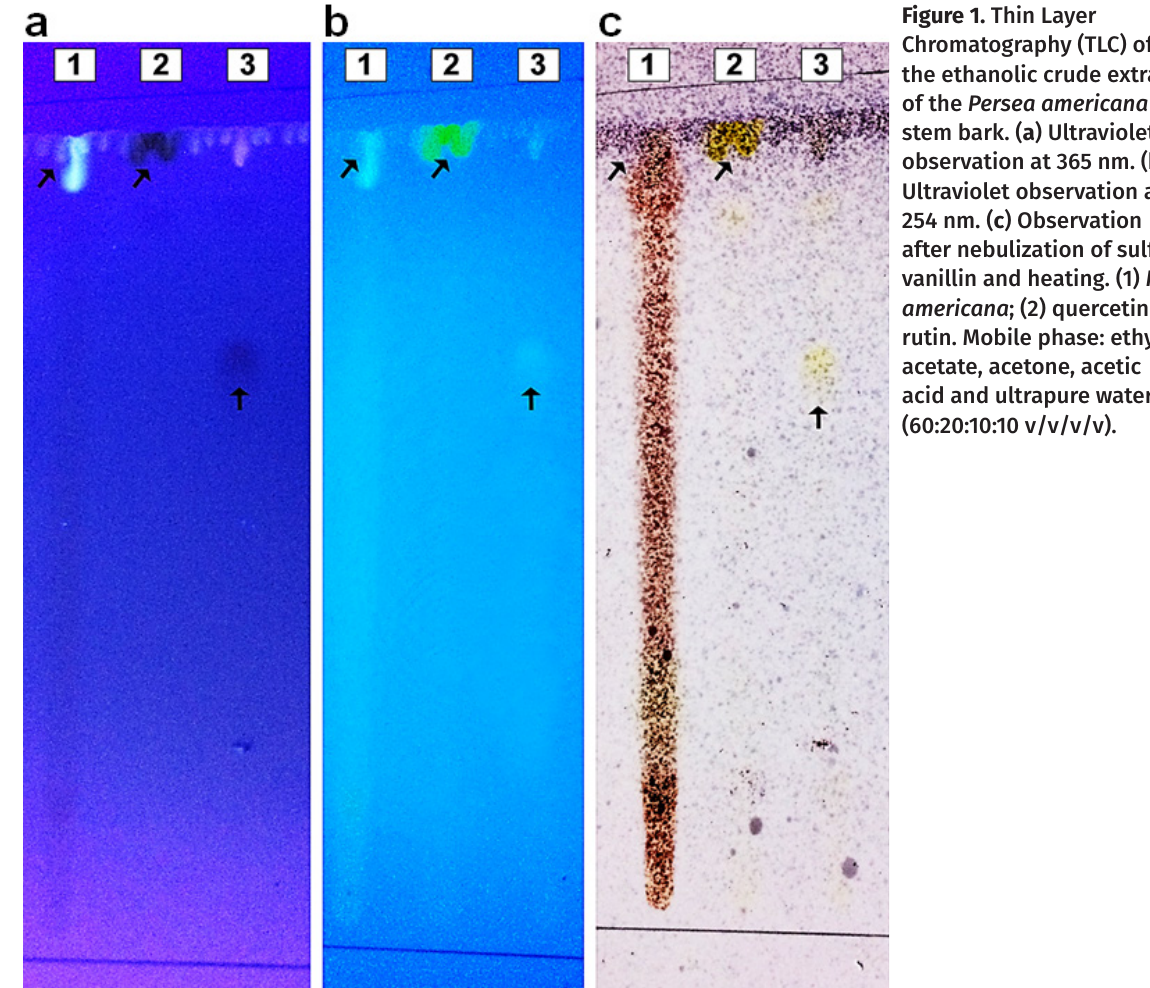
Figure 1. Thin Layer Chromatography (TLC) of the ethanolic crude extract of the Persea americana stem bark. ( a ) Ultraviolet observation at 365 nm. ( b ) Ultraviolet observation